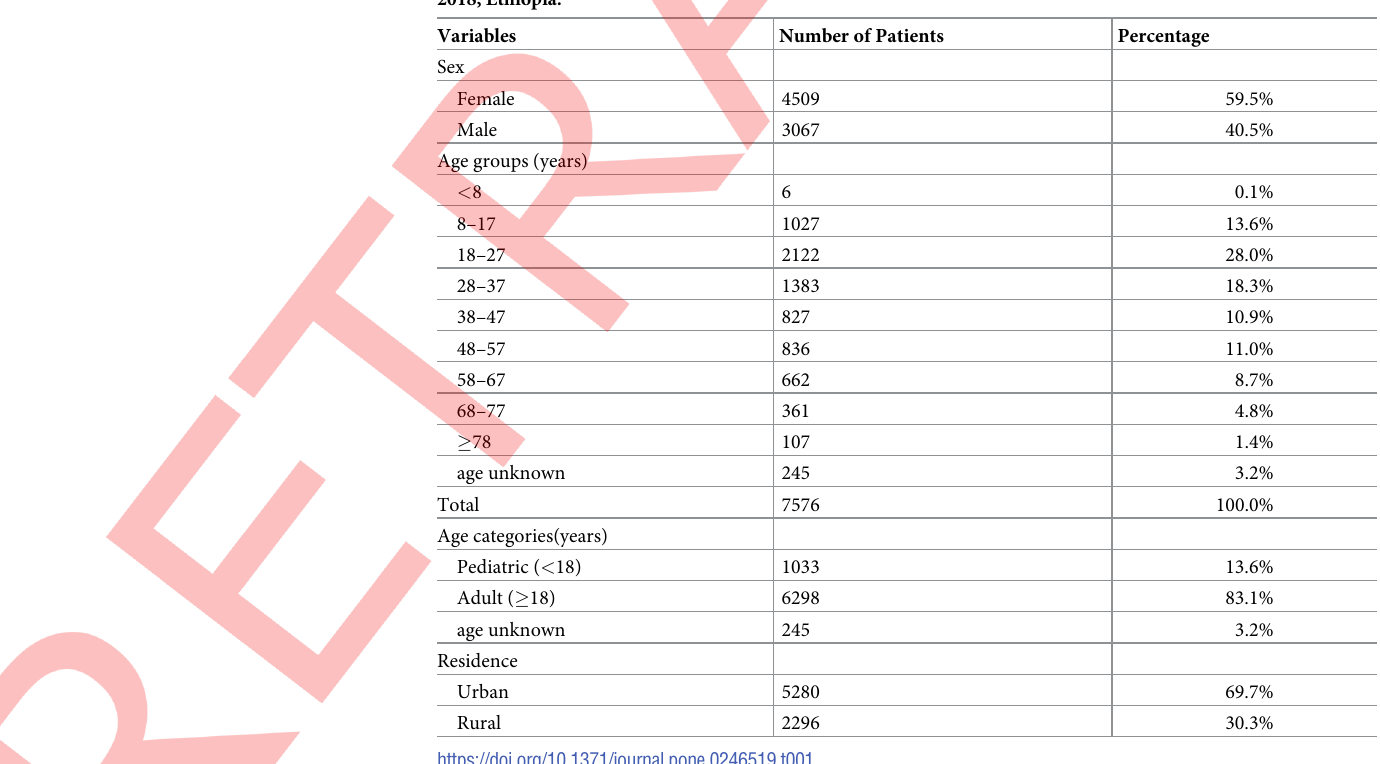
Table 1. Socio-demographic characteristics of study participants with a hospital diagnosis of cardiopathy, 2015– 2018, Ethiopia.